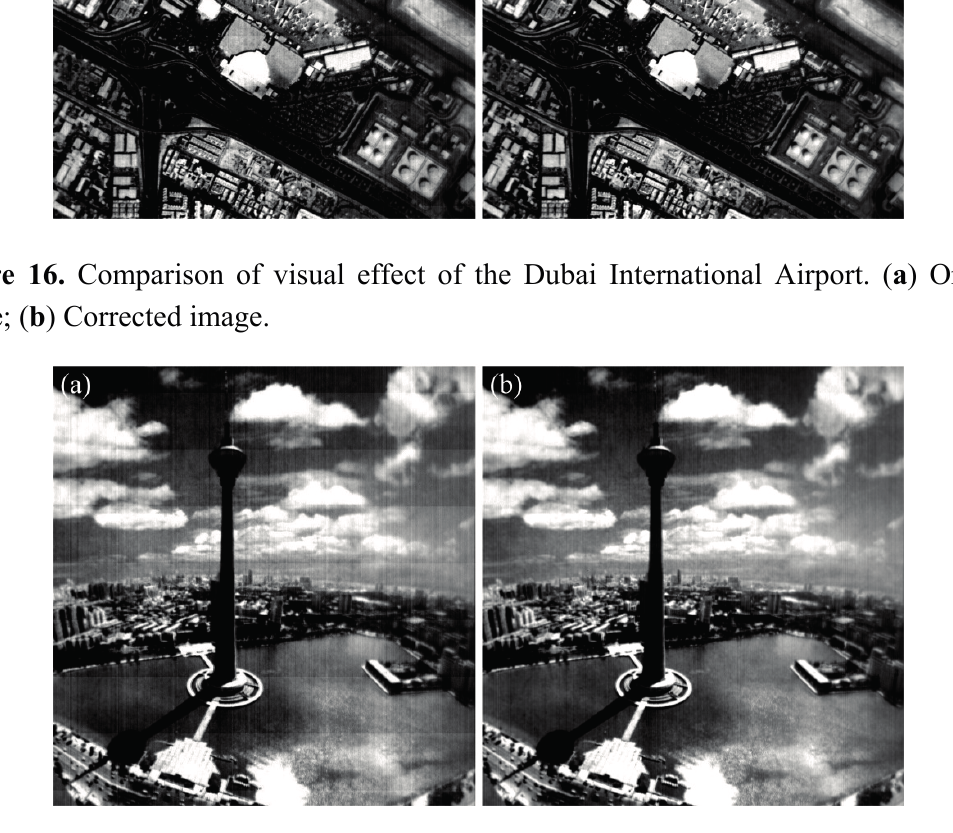
Figure 17. Comparison of visual effect of the Tientsin Tower. ( a ) Original image; ( b ) Corrected image.